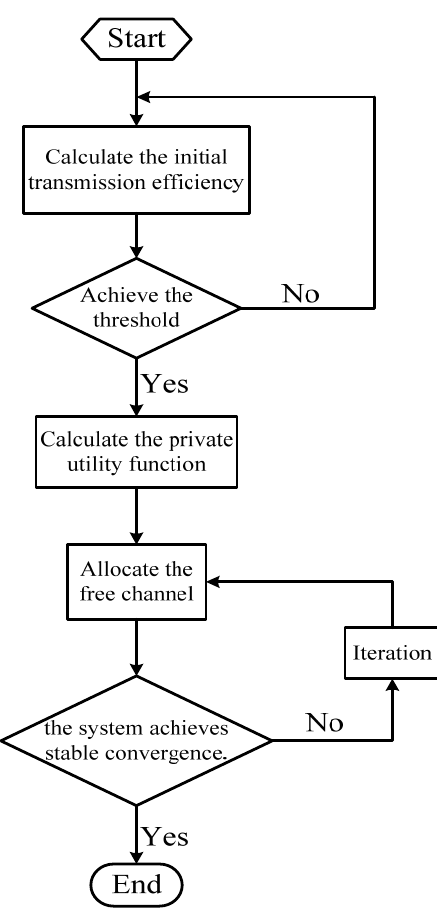
Figure 3. Algorithm flow